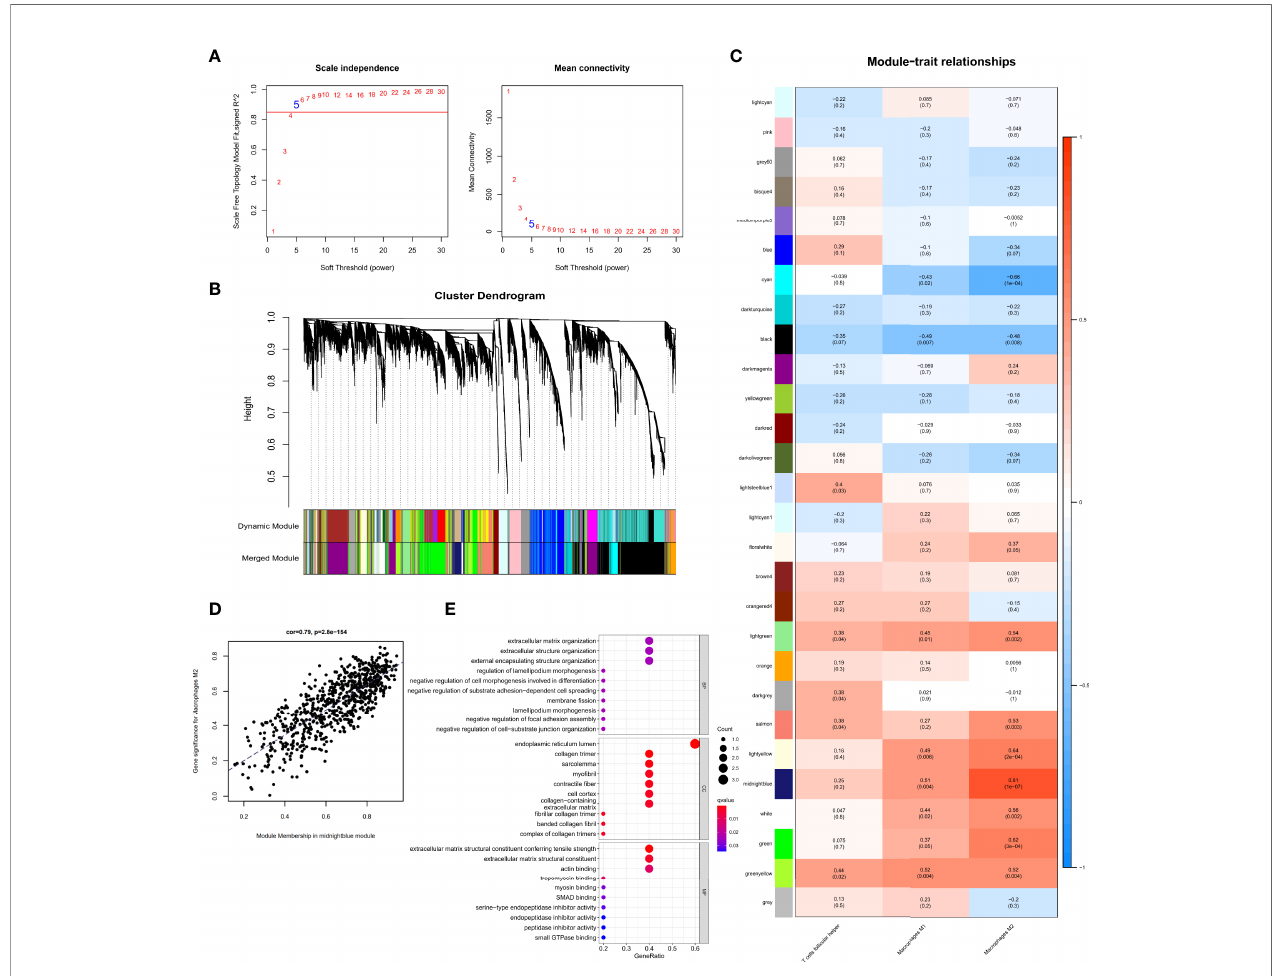
FIGURE 4 | Identi fi cation of immune cell-related genes using WGCNA. (A) Analysis of the scale-free fi t index for soft threshold powers ( b =5). (B) Hierarchical dendrogram of the identi fi ed co-expression modules, indicated by color coding. (C) Heatmap plot of correlation between the gene module and immune cell type in fi ltration. Strength of the correlation is depicted by its color. (D) Correlations between the gene module memberships and gene signi fi cance for the midnight-blue module associated with M2 macrophages. (E) Bubble plots of GO enrichment analysis with hub genes in the midnight-blue